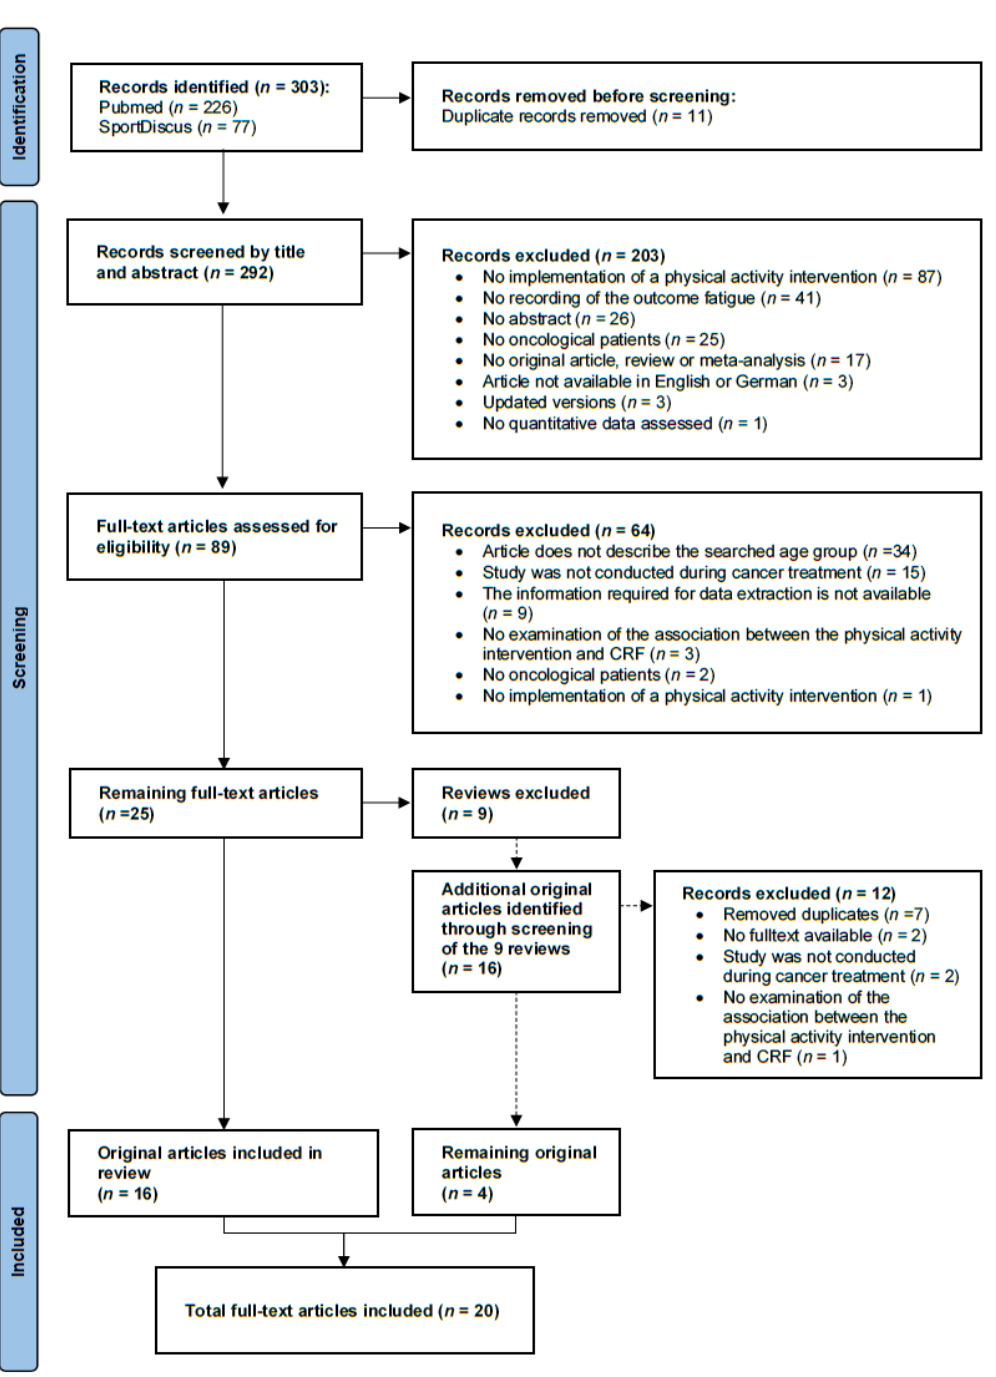
Figure 1. PRISMA flowchart of the study selection.